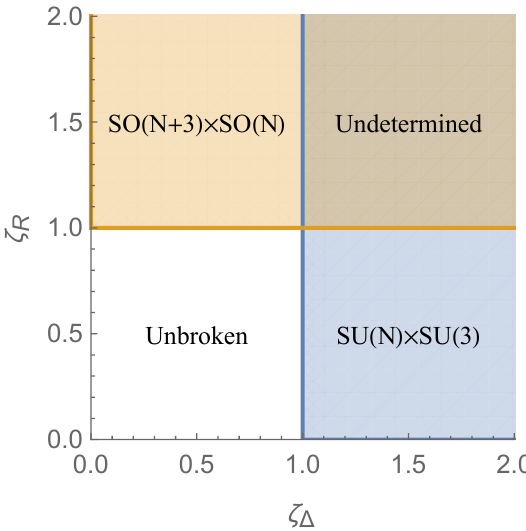
/ (4 π 2 ) and ζ R = κ R Λ 2 / (4 π 2 ) UV UV